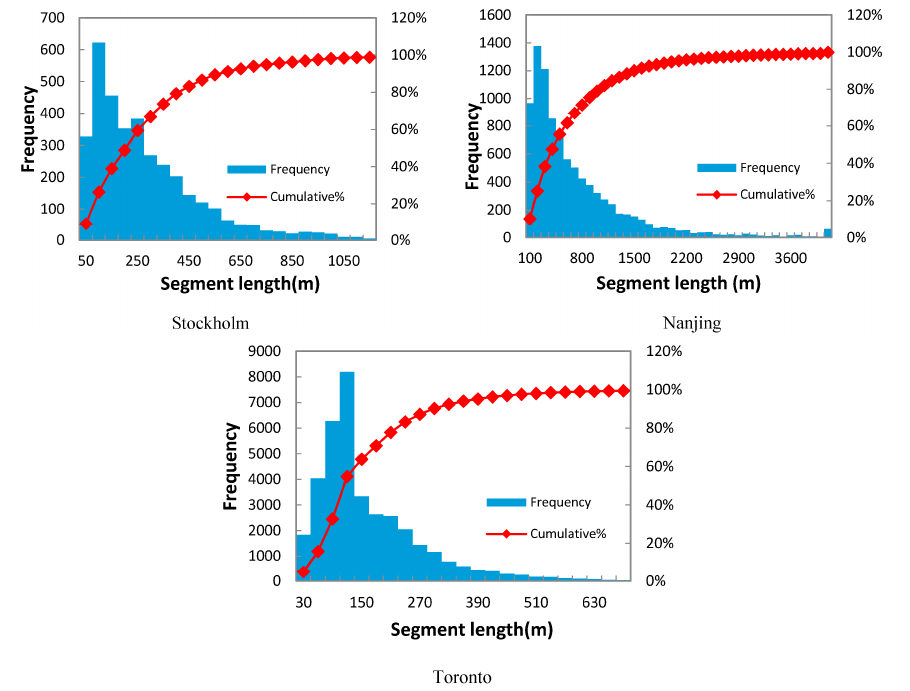
Figure 2. Distance distribution histograms of urban street systems of Stockholm, Nanjing, and Toronto.